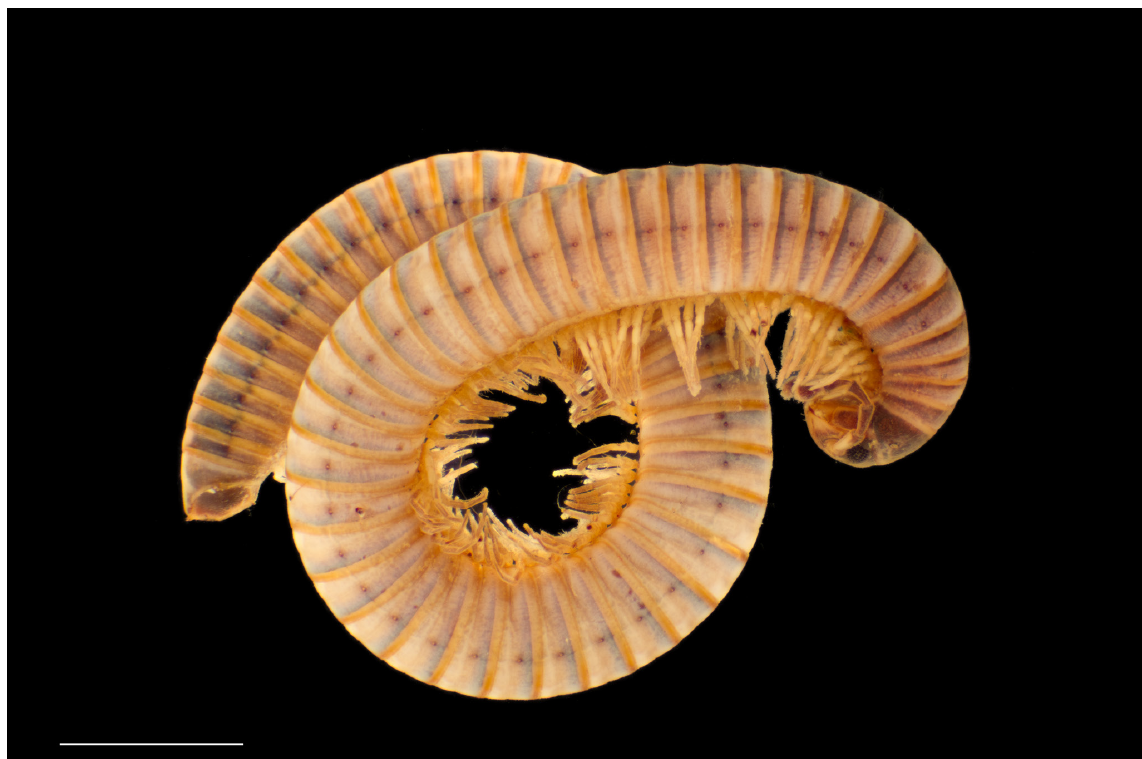
Fig. 7. Hoffmanides dissutus (Hoffman, 1963), ♂, from Udzungwa Mts National Park. Photograph by A. Illum. Scale bar = 5